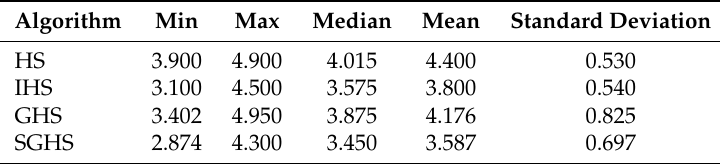
Table 2. Details of optimization results from 20 trials of Problem